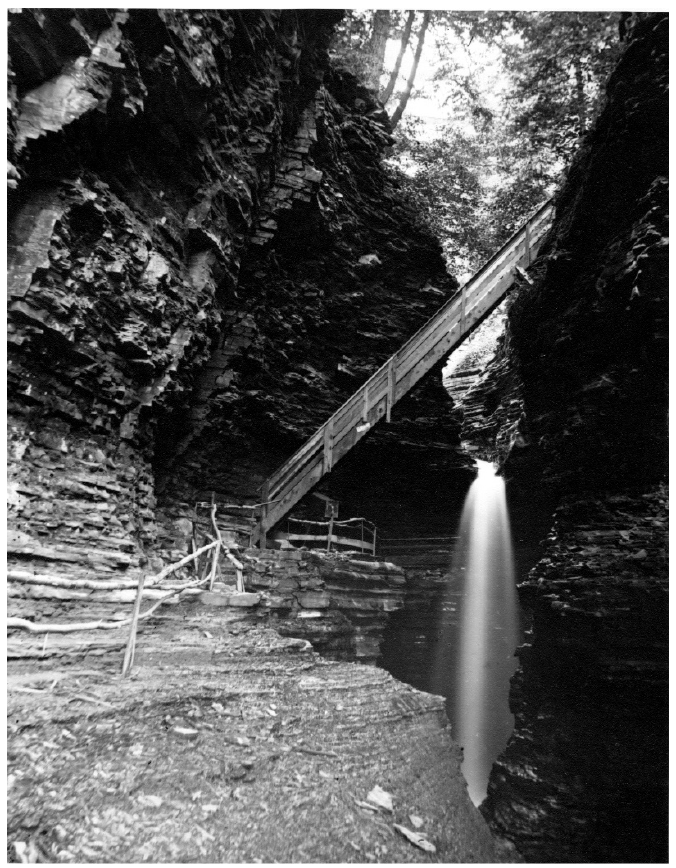
Figure 7. Cavern Cascade, ca. 1890. Photo used with permission: NY State Office of Parks, Recreation & Historic Preservation; parks.ny.gov (accessed on 12 June